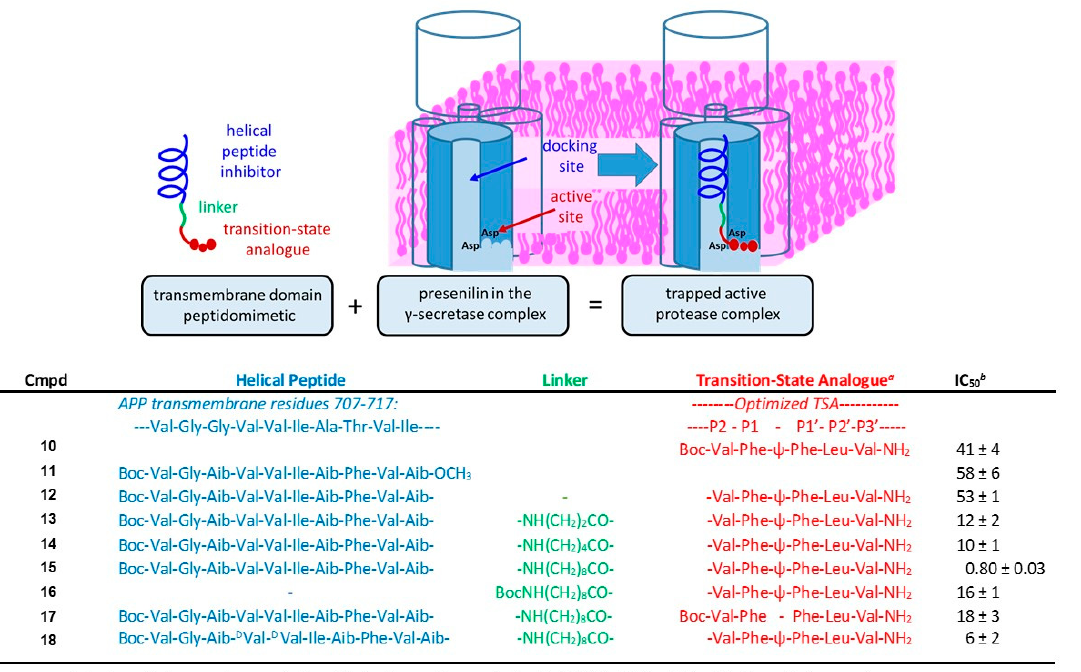
Figure 7. Discovery of structural probes for γ -secretase. Schematic shows the design concept. Helical peptide inhibitors (HPIs) directed to the substrate docking exosite were conjugated through a variable linker to transition-state analogue inhibitors (TSAs) directed to the active site. Presenilin (blue-grey) and other components of the γ -secretase complex (outlined) are shown schematically in the absence and presence of a hybrid HPI-TSA inhibitor. The active site contains two catalytic transmembrane aspartates and three hydrophobic pockets S1 ′ , S2 ′ and S3 ′ that must be engaged for intramembrane proteolysis. Linking TSA 10 to HPI 11 through a 10-atom linker led to stoichiometric inhibitor 15 .